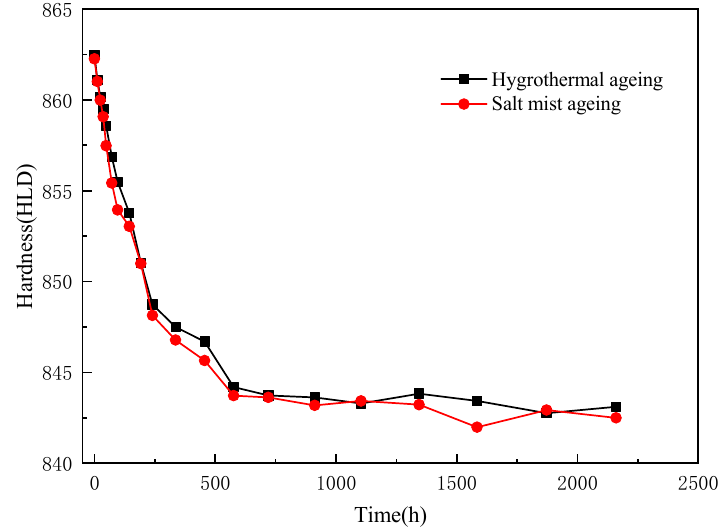
Figure 8. Changes in the hardness of the epoxy resin casting sheets before and after ageing. The variation in the hardness of the epoxy resins followed a similar trend in the two ageing modes. The hardness gradually decreased over time. The rate of the